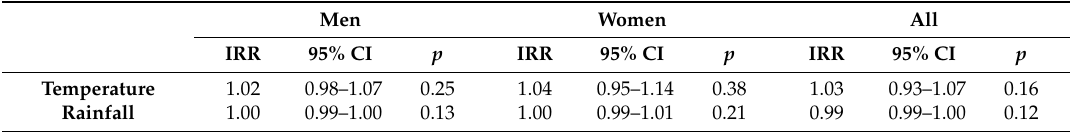
Table 4. Conditional Poisson models for the cumulative effects of weather variables on daily suicides among men and women in five Colombian cities, 2005–2015 Men Women All IRR 95% CI p IRR 95% CI p IRR 95% CI p Temperature 1.02